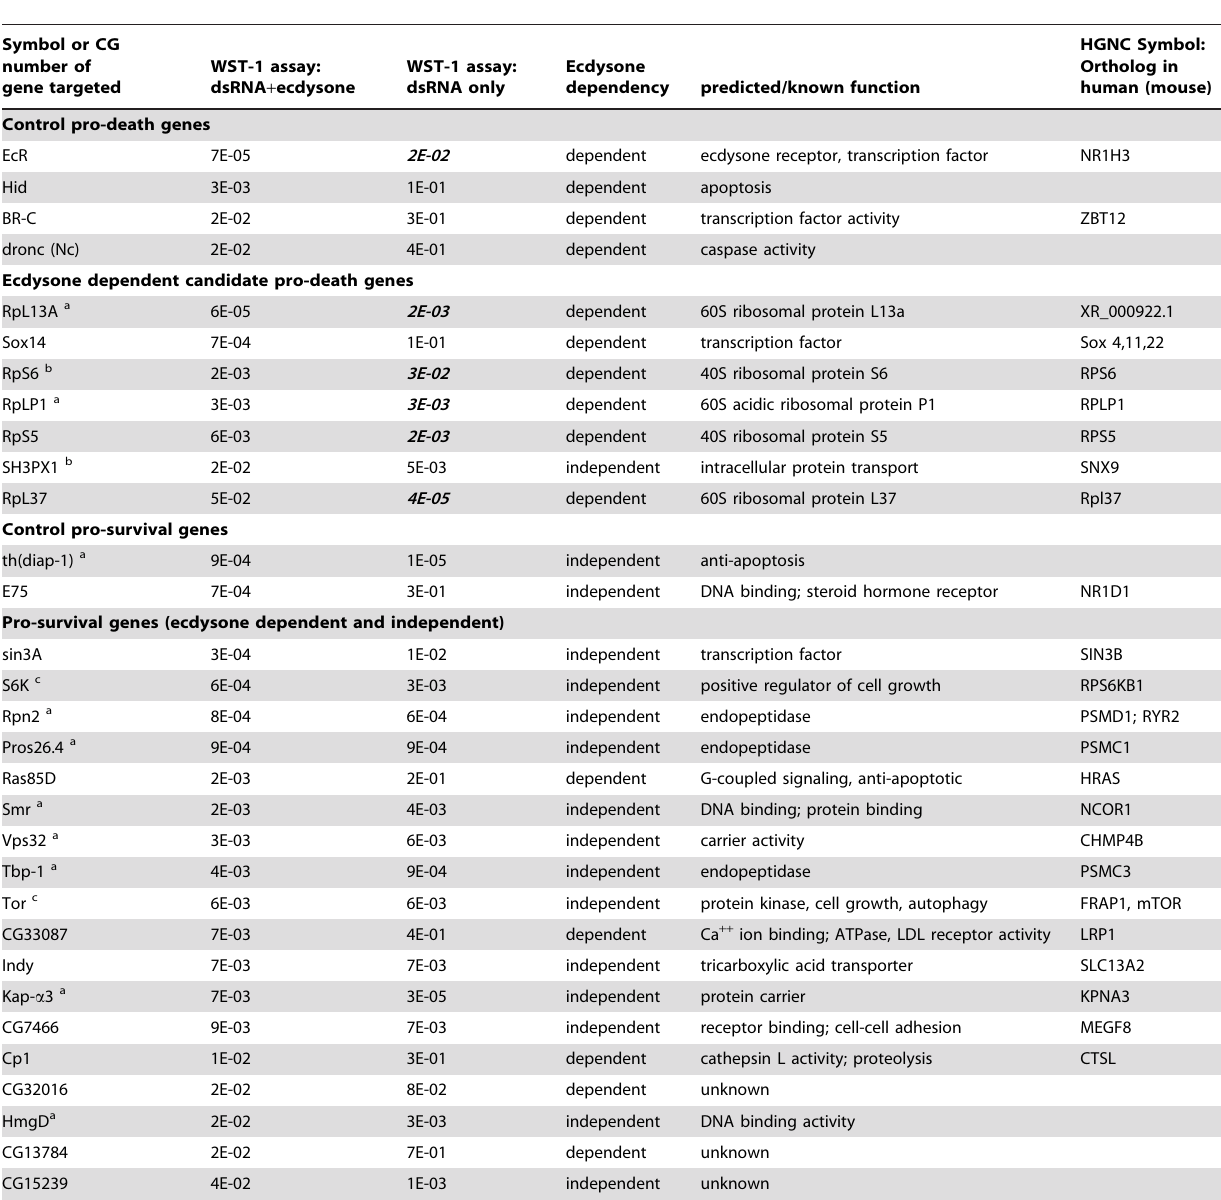
Gene symbols, CG numbers (column 1), and functions (column 5) are from Flybase [58]. The indicated Ortholog symbols (column 6) are from the HUGO Gene Nomenclature Committee (HGNC). P-values in columns 2 and 3 were calculated by comparing the WST-1 reading (A450–A650) from RNAi of the gene of interest to the WST-1 reading from RNAi of the human (Hs) negative control (NM_138278). Ecdysone dependent means that the observed viability effects of RNAi depended on the presence of ecdysone. Italicized and bolded P-values in column 3 indicate that these genes showed a pro-survival effect in the absence of ecdysone. Each RNAi treatment had three replicates and the assay was conducted at least twice. Superscript symbols a, b, and c indicate that these genes were identified in other related RNAi screens; a=Boutrous et al., 2004 [49]; b=Bjo ¨ rklund et al., 2006 [47]; c=Bettencourt Dias et al., 2004